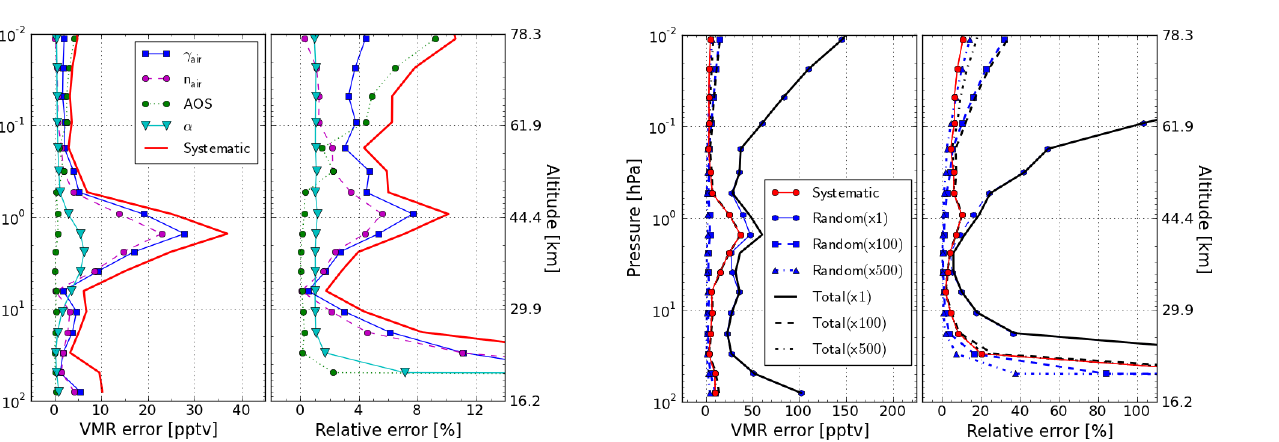
Fig. 8. Same as Fig. 4 except for the systematic error. The total systematic error and the errors from the main error sources are shown. Blue: 3% uncertainty in γ air . Purple: 10% uncertainty in n air . Green: 10% uncertainty in the width of the AOS response function. Cyan: 20% uncertainty in α . Red: total systematic error.